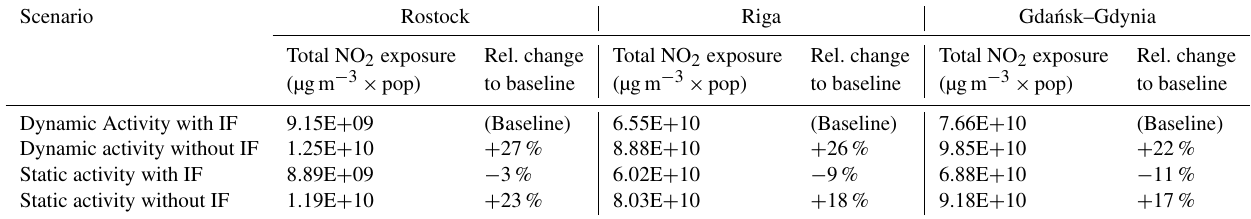
Table 6. Comparison of total exposure to NO 2 in each city for simulations with static and dynamic population, with and without ME- and seasonal-specific IFs. The approach used in this study (dynamic activity with IF) represents the baseline (100%). The different scenarios are compared with the total NO 2 exposure for each urban domain calculated as the product of NO 2 concentrations (in m − 3 ) and the dynamic